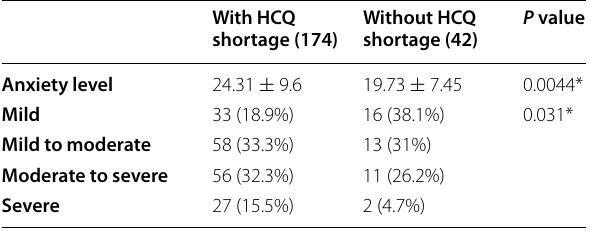
Table 3 Anxiety “Hamilton Anxiety Rating Scale” in RA patients during COVID‑19 outbreak